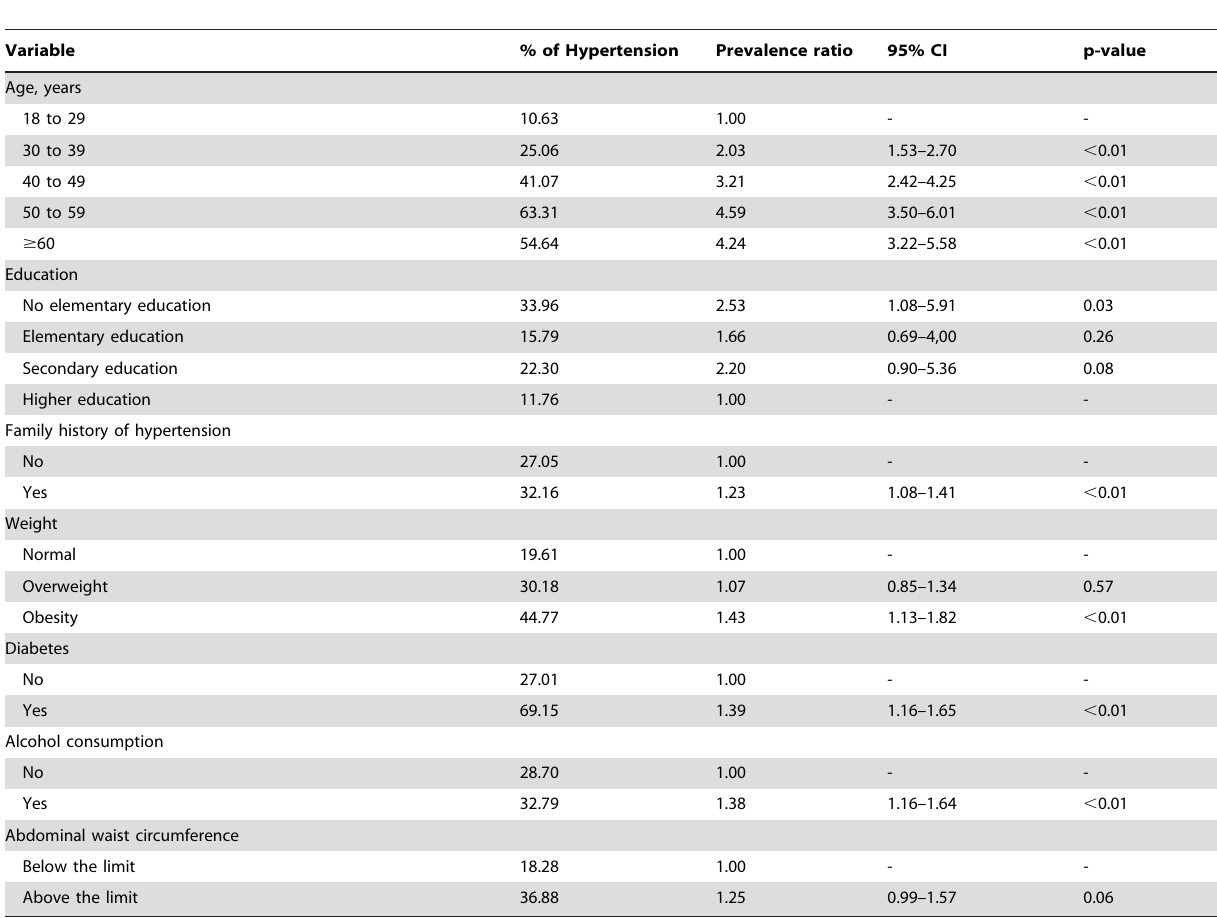
Table 2. Associations between demographic, socioeconomic and clinical variables and the prevalence of arterial hypertension, based on Poisson multiple regression analysis